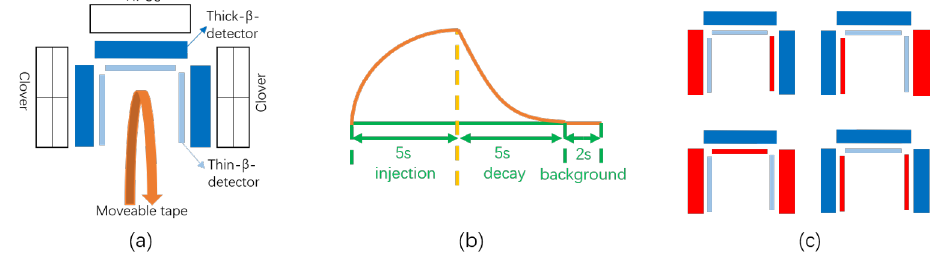
Figure 1. The main configuration of the detection system (a). The time chopper information (b). The schematic drawing of β detector combinations used to trigger the γ -ray spectra